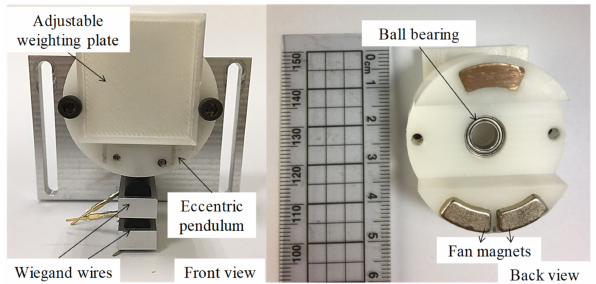
Figure 19. Energy harvester composed of fan magnets and Wiegand